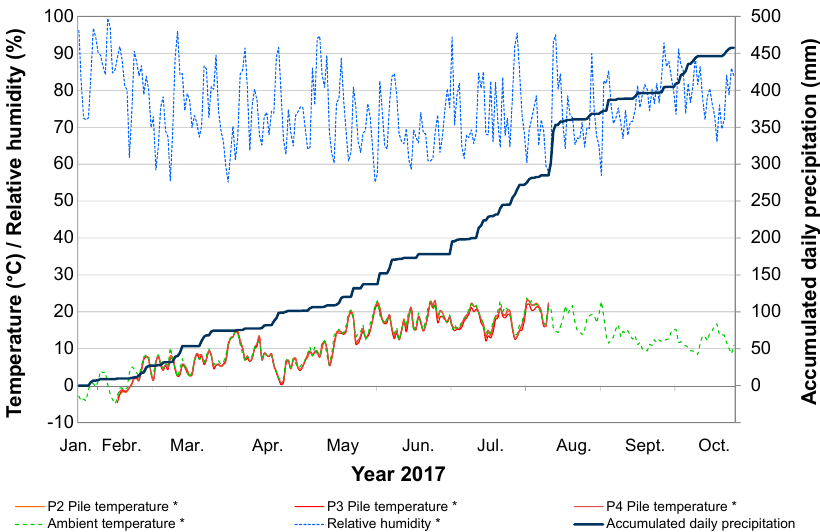
Figure 7. Weather conditions and pile temperatures during storage trials P2–P4 in Schwarzbach (* daily averages), cf. Appendix A, Figure A1.